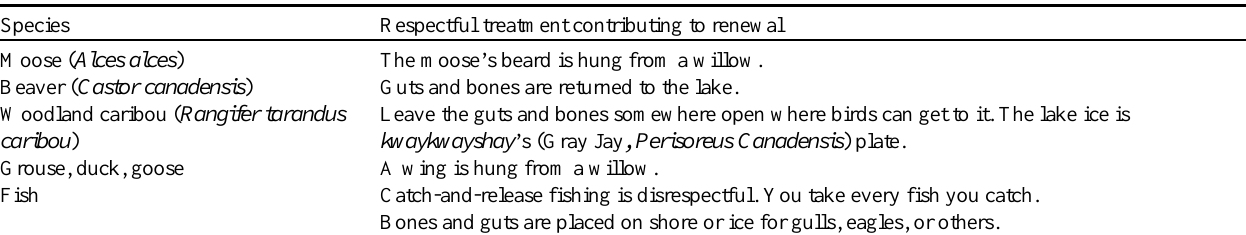
Table 1 . Traditions that demonstrate respectful use and help maintain future abundance.